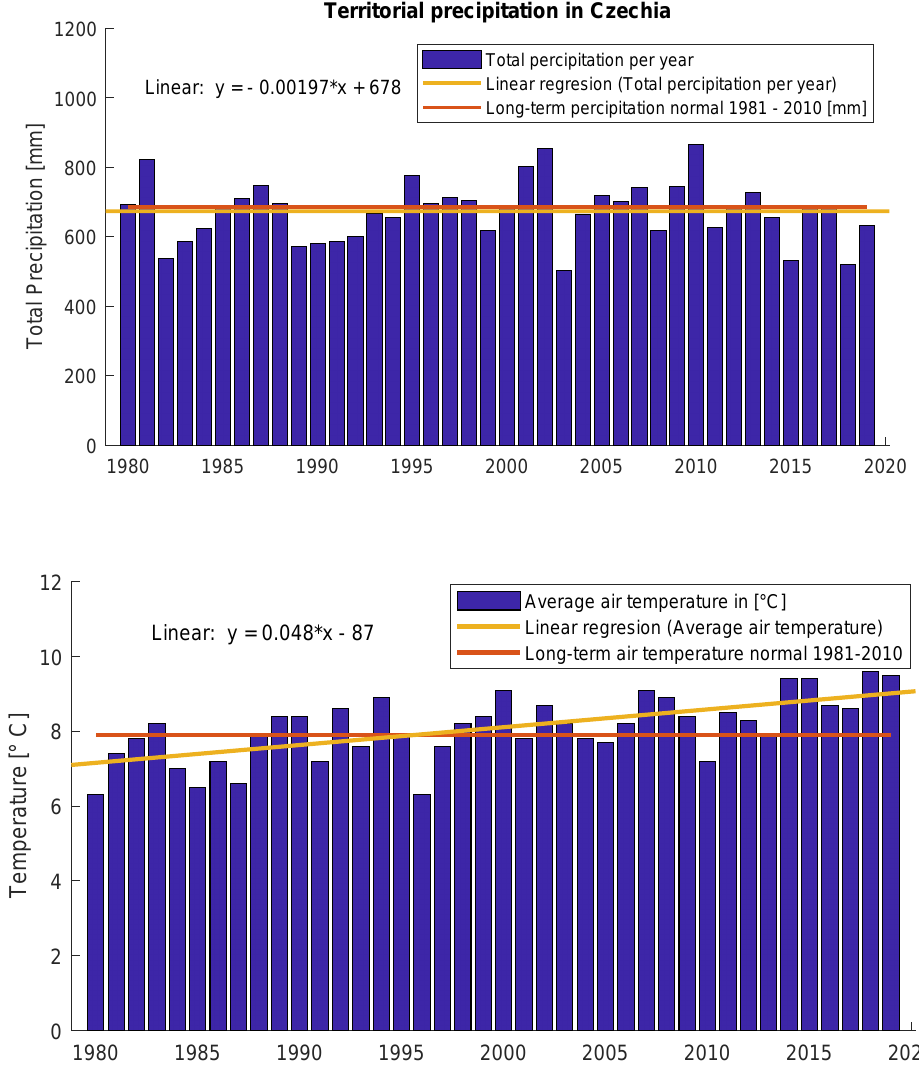
Figure 1. Territorial precipitation and territorial temperature in Czechia